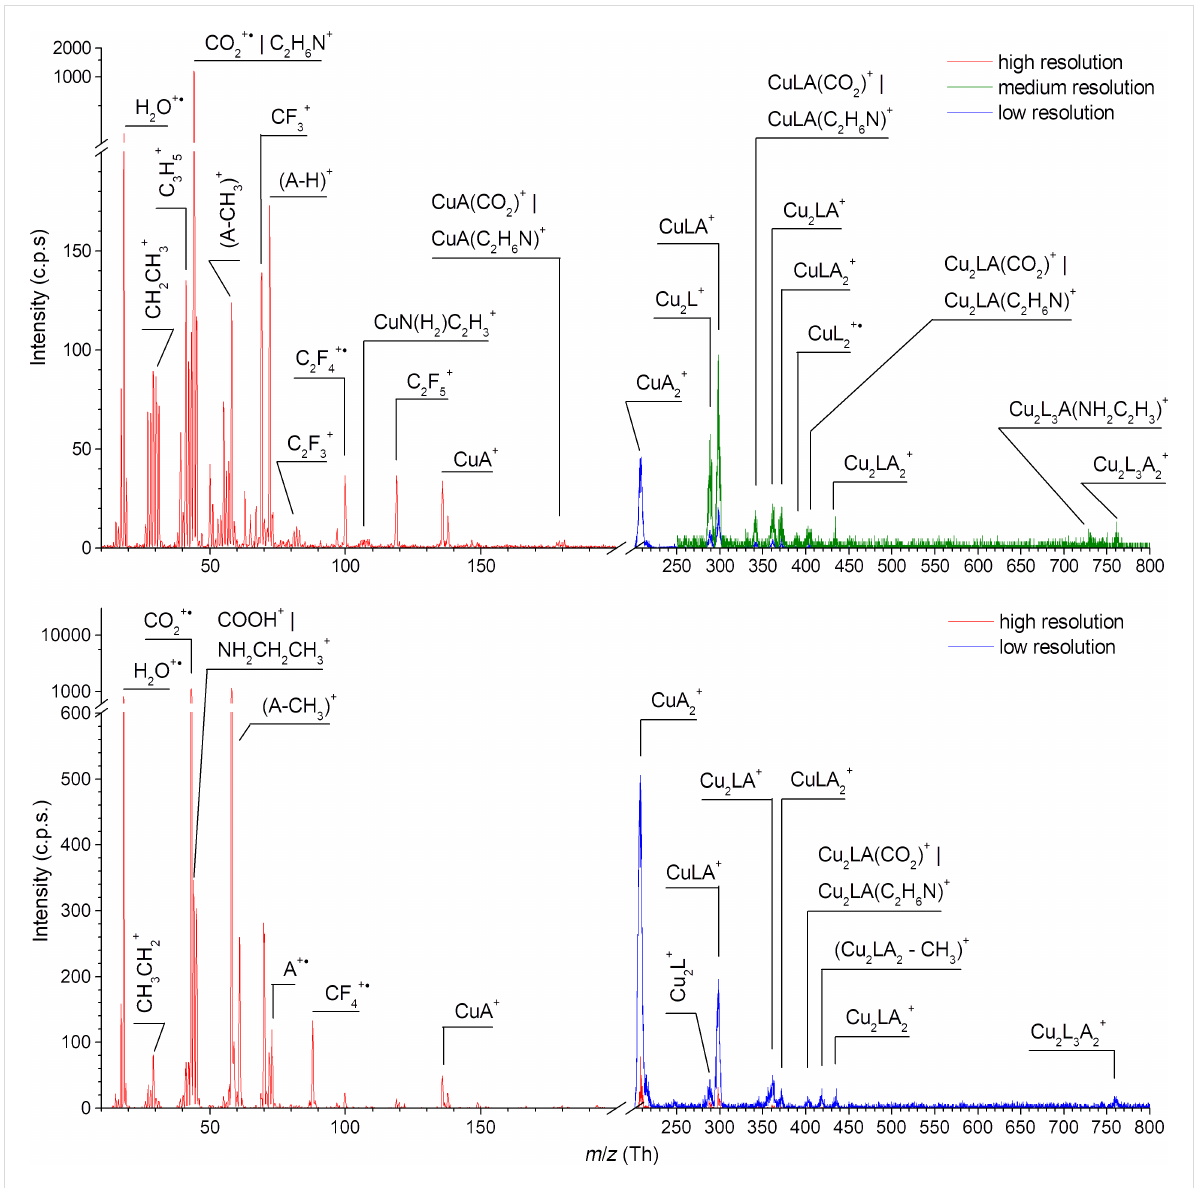
Figure 5: Mass spectrum of [Cu 2 ( s -BuNH 2 ) 2 (µ-O 2 CC 2 F 5 ) 4 ] molecule (top spectrum) over the range m / z 10–800 obtained at electron energy 70 eV and mass spectrum of [Cu 2 ( t -BuNH 2 ) 2 (µ-O 2 CC 2 F 5 ) 4 ] (bottom) obtained at similar conditions (temperature of the beam source of ≈ 100 °C). For both molecules the spectral range below m / z 200 was measured with higher mass resolution (red line) but above m / z 200 (blue line) with low mass resolu- tions to increase the signal. For [Cu 2 ( s -BuNH 2 ) 2 (µ-O 2 CC 2 F 5 ) 4 ] molecule (top spectrum) the range above m / z 250 was also measured with medium resolution (green